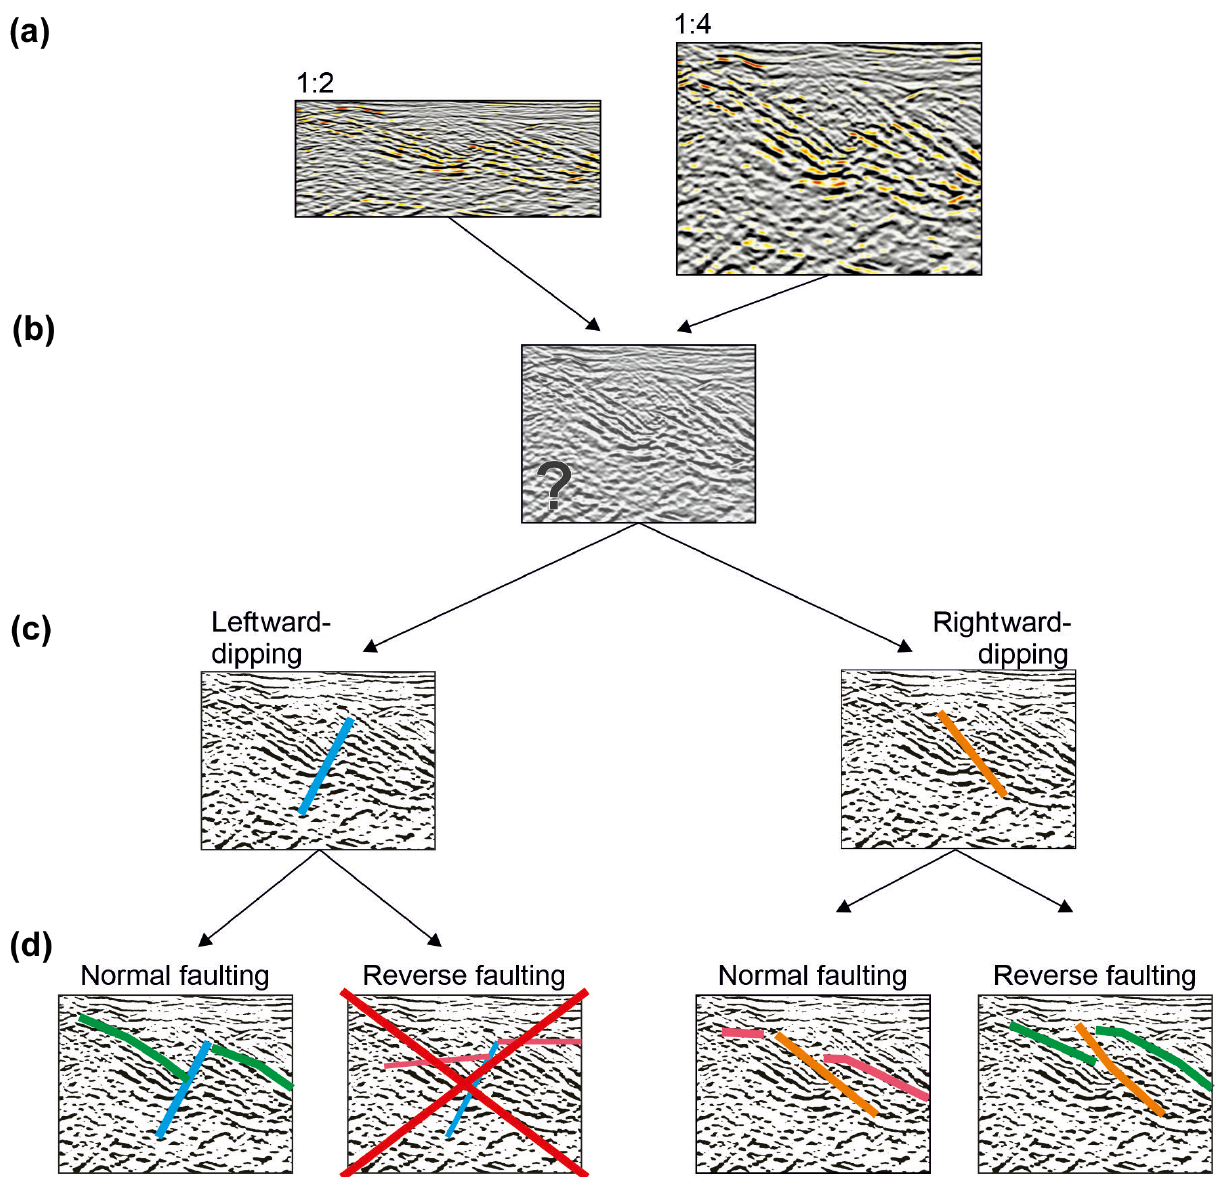
Figure 9. Proposed interpretation sequence. (a) The seismic images were presented in both 1 : 2 and 1 : 4 vertical exaggerations. (b) Inde- pendently of the image interpreted, the participants of the experiment faced the problem of how to interpret the rightward-dipping structures and the chaotic seismic fabric. (c) Participants interpreted the central fabric either as a leftward-dipping (blue) or rightward-dipping (orange) fault, which consequently triggered (d) the horizon interpretation determining the motion (normal, green horizons; and reverse, pink hori- zons) of the fault. The leftward-dipping, reverse faulting interpretation (crossed out in red) is too difficult to fit to the seismic data, and so only one participant chose this